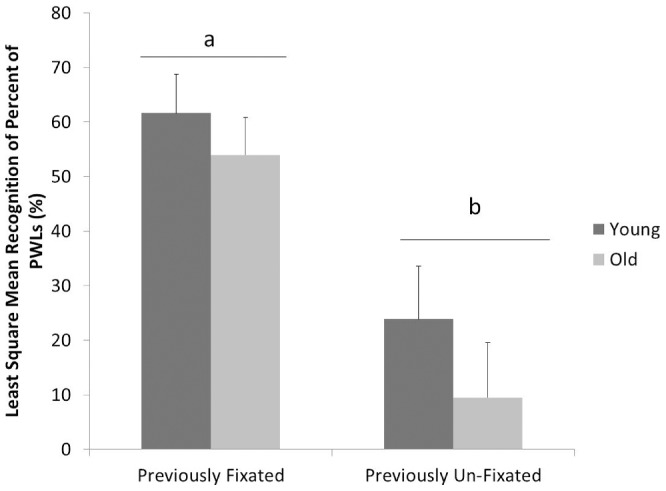
Estimated percentage of correctly recognized PWLs contingent on fixation.